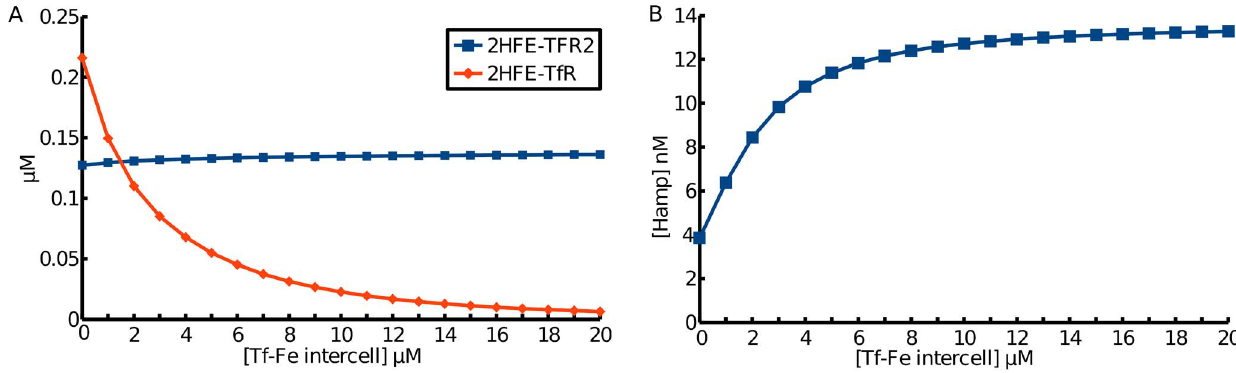
Figure 3. Simulated steady state concentrations of metabolites in response to increasing serum Tf-Fe. Increasing HFE-TfR2 complex as a result of HFE-TfR1 reduction induces increased hepcidin.